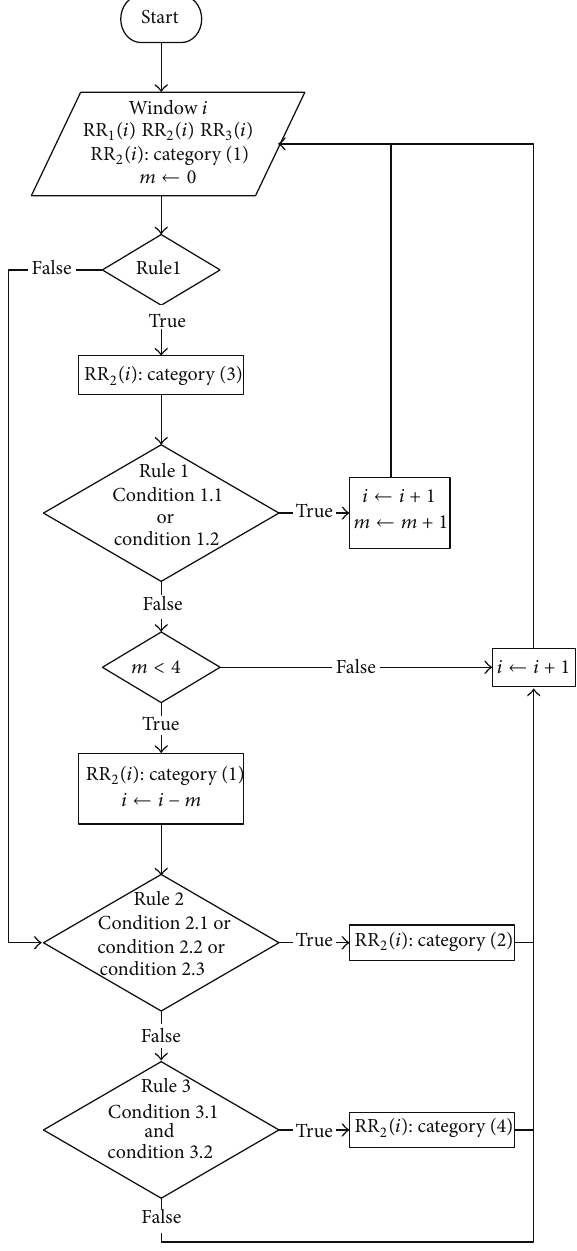
Figure 5: Arrhythmia beat classification block diagram.